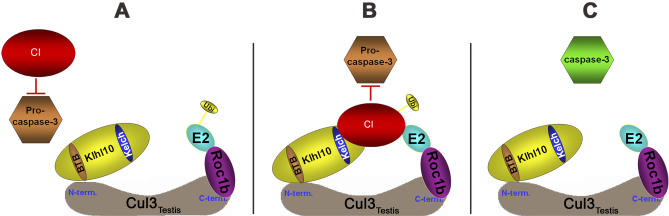
Working Model for a Cullin-3–Based Ubiquitin Ligase Complex in the TestisThe diagram represents the assembly of the testis-specific Cullin-3–containing ubiquitin ligase (E3) and its proposed function in caspase activation during spermatid individualization.(A) The model suggests that once an active Cul3Testis-Roc1b-Klhl10 E3 ubiquitin ligase complex is assembled, it recruits a caspase inhibitor “CI” protein (red) via the Kelch domain of the substrate recruitment protein Klhl10 (yellow). A candidate for this caspase inhibitor is dBruce, a giant BIR-domain-containing ubiquitin-conjugating enzyme [12,35,36,103,104]. dBruce can physically interact via its BIR domain with Klhl10 (see Figure 10), and loss of dbruce function leads to spermatid death [12]. Therefore, dBruce has biochemical and genetic properties expected for the postulated “CI” protein.(B) Next, the ubiquitin-conjugating enzyme (E2, blue), which is recruited by the RING finger protein Roc1b (purple), ubiquitinates the “CI” protein. (C) Subsequent degradation of this inhibitor allows the activation of caspases at the onset of spermatid individualization process.